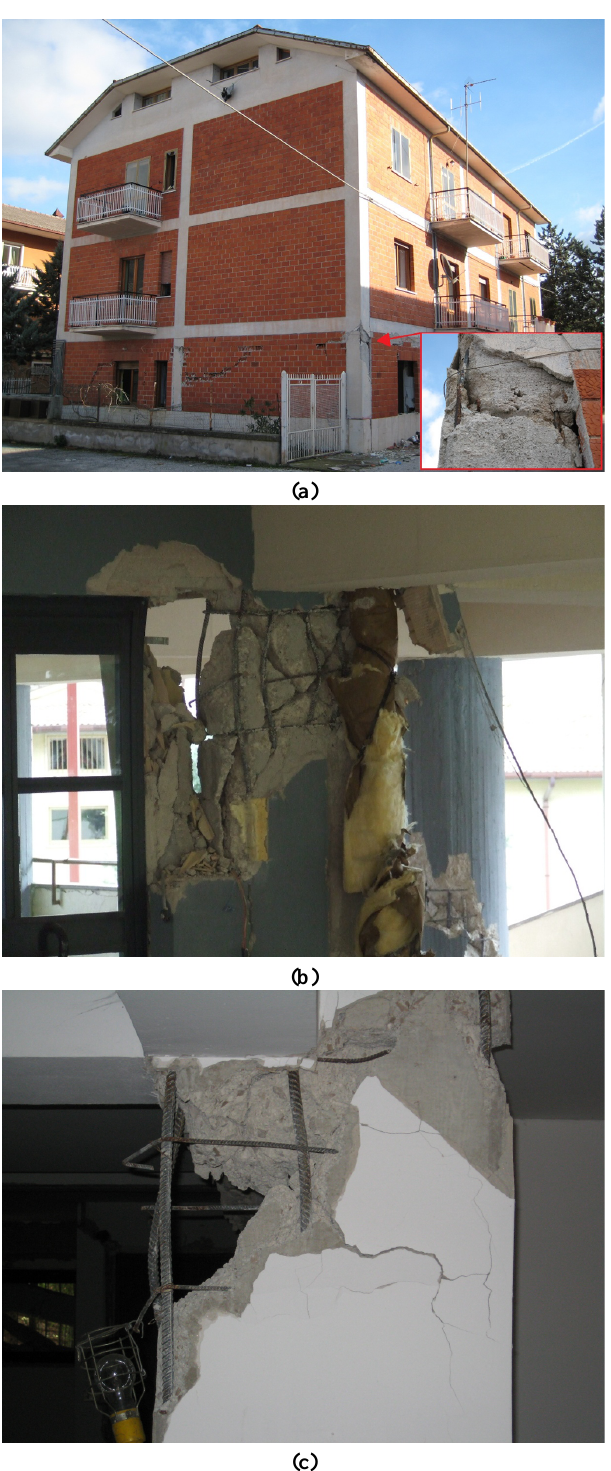
Fig. 3. Damage level 3 (a) and damage level 4 (b) , (c) .